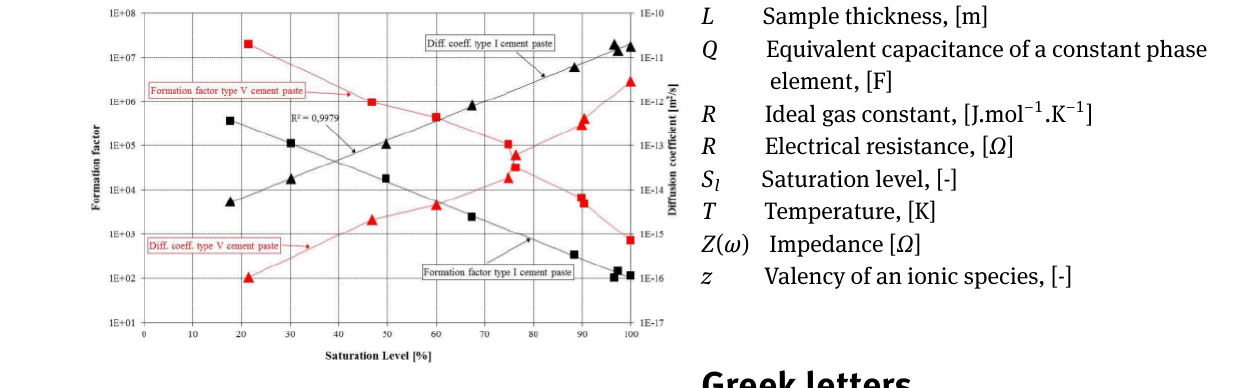
Figure 6: Formation factor and chloride diffusion coefficient as a function of the water saturation